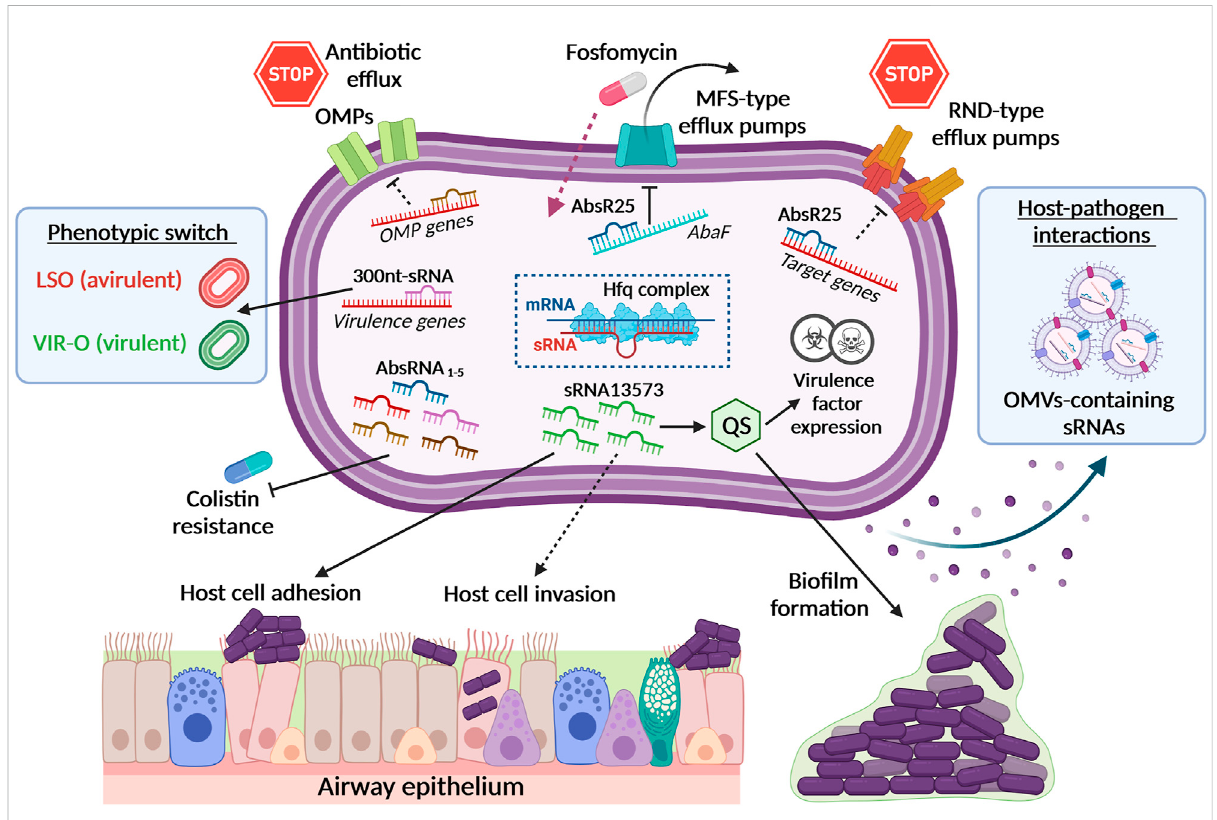
FIGURE 1 Small RNAs (sRNAs) in A. baumannii physiology, antibiotic-resistance and virulence. The fi gure summarizes A. baumannii sRNAs associated with their targetsandrelativefunctions.Blackdottedlinesrepresentputativeorunderexploredroles.Bythedownregulationofthe abaF gene,sRNAAbsR25affectsthe function of the major facilitator superfamily (MFS) transporter, thereby leading to an increased susceptibility to fosfomycin. Other sRNAs can regulate the expressionof other ef fl ux pumpsandouter membrane proteins(OMPs). The sRNA 13573 was foundto be overexpressed during A. baumannii bio fi lm